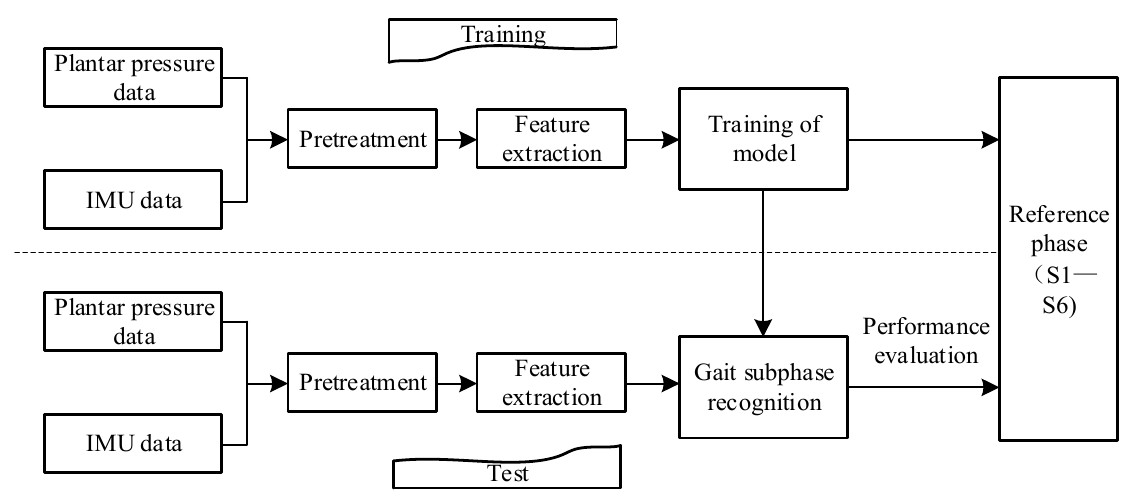
Figure 13. Design block diagram of gait recognition algorithm.